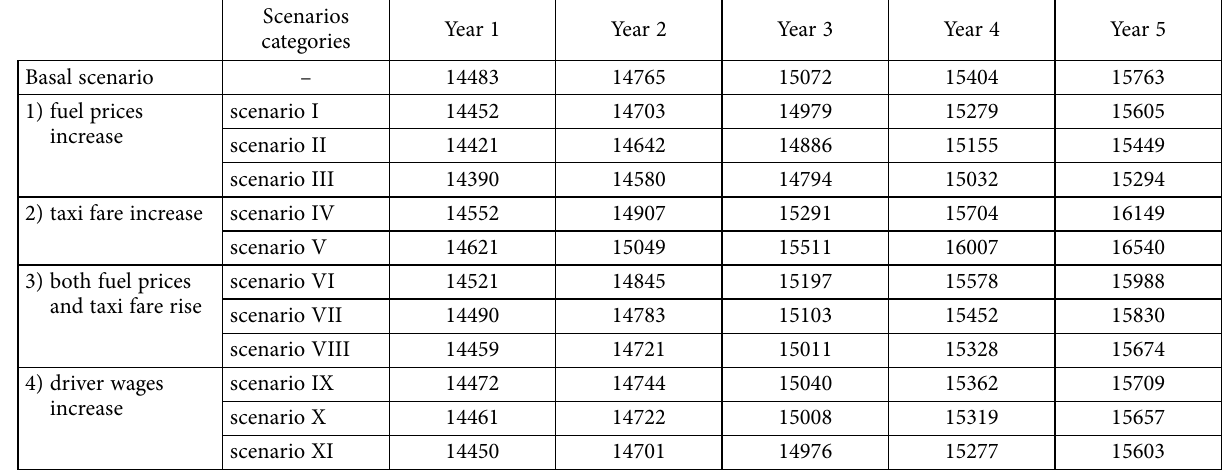
Table A4. The statistics of taxi supply for taxi operation simulation